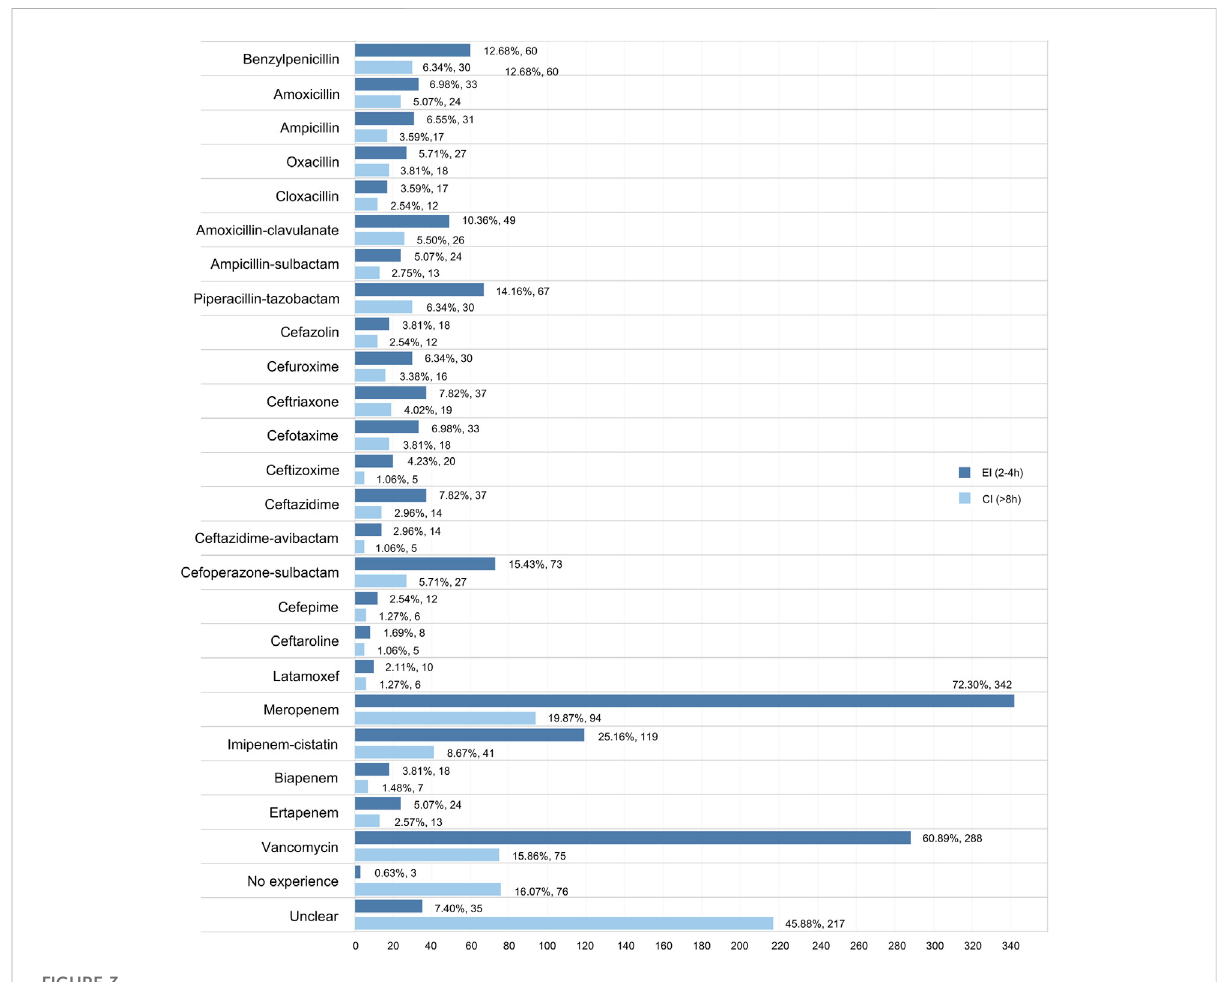
FIGURE 3 Participants ’ responses about the experience of EI/CI approach in 24